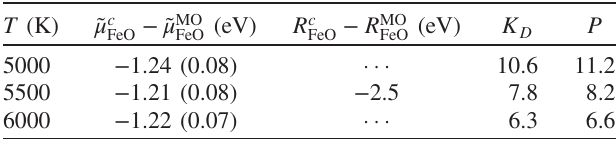
TABLE IV. Temperature T , excess chemical potential differ- − ˜ μ MO ence of FeO between the core and the magma ocean ˜ μ c FeO FeO − with error given in brackets, heat of reaction difference R c FeO R MO as one FeO unit is transferred from the magma ocean to the FeO c c core, distribution coefficient K D ¼ ½ð c c Þ =c MO (cid:3) and partition Fe Fe O coefficient P ¼ K D =c c . All calculated values refer to a pressure Fe of 124 GPa for a silicate melt comprising 50% SiO 2 , 44% MgO, and 6% FeO and a liquid metal comprising 95% Fe and 5%